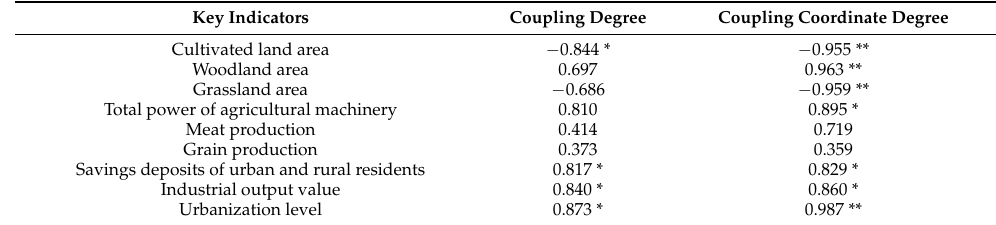
Table 10. Correlation between the coupling degree/coupling coordinate degree and key indicators. Key